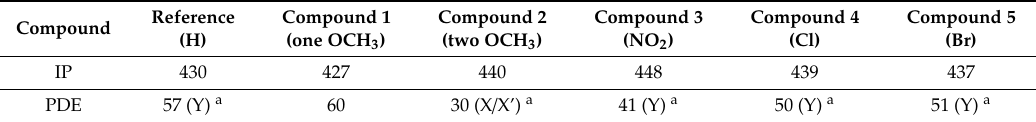
Table 2. Calculated ionization potential (IP) and proton dissociation enthalpy (PDE) values (kJ / mol) in methanol.